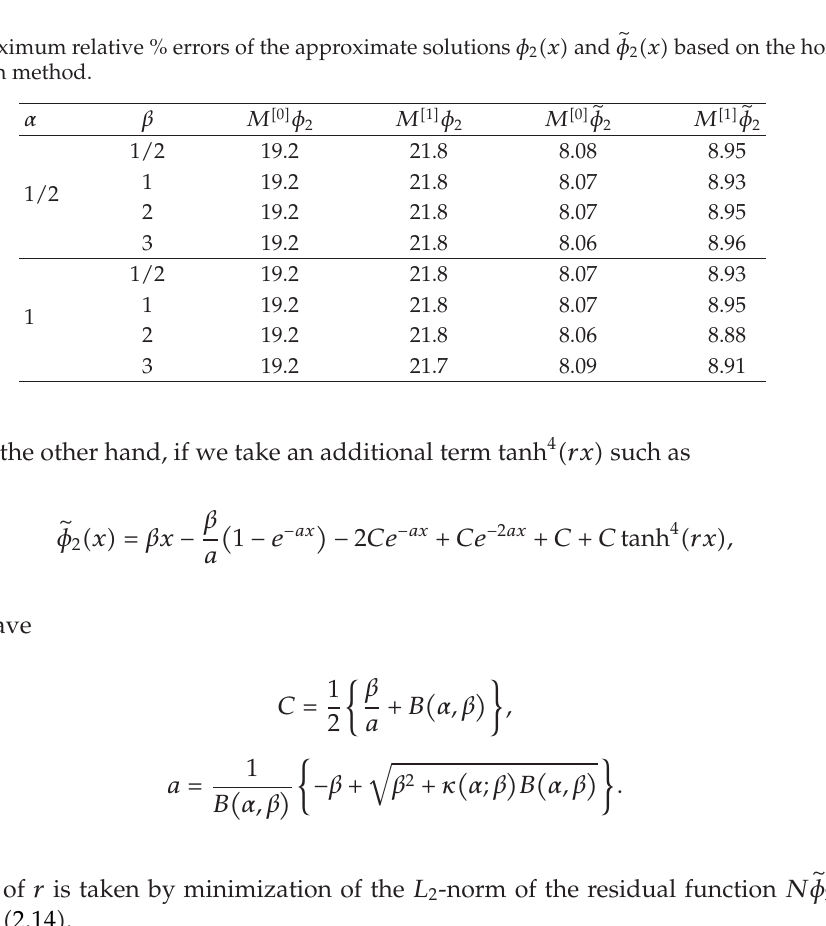
(cid:20) φ 2 (cid:3) x (cid:4) based on the homotopy